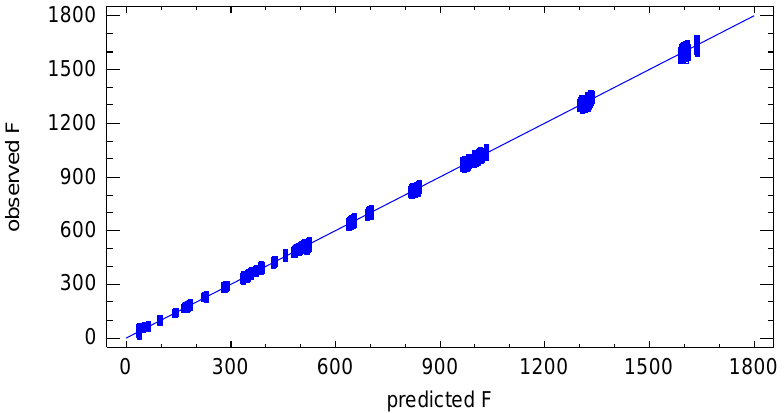
Figure 2. Goodness-of-fit graphic of the lineal model. Observed vs. adjusted radiometric values. It can be observed the linearity of the process. The separation with respect the straight line is the error or residual.